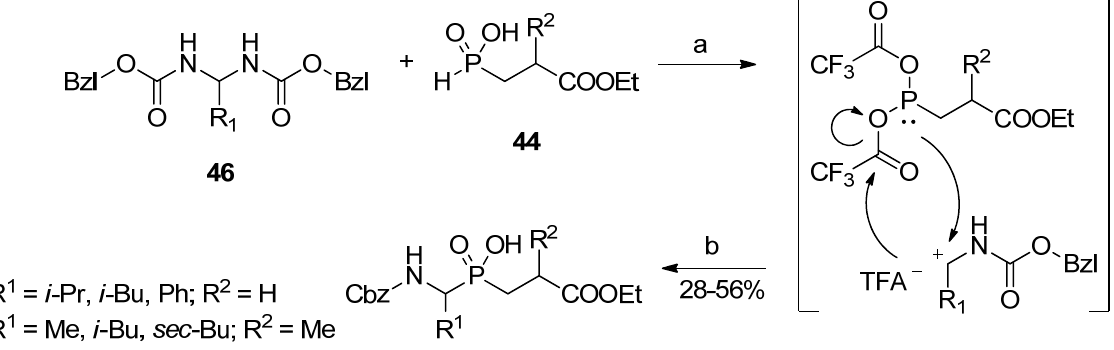
Scheme 13. Synthesis of phosphinic dipeptides in the reaction of benzyl biscarbamate and a 2-ethoxycarbonylethyl- H -phosphinic acid in the presence of trifluoroacetic anhydride (TFAA) and a suggested mechanism for substrate